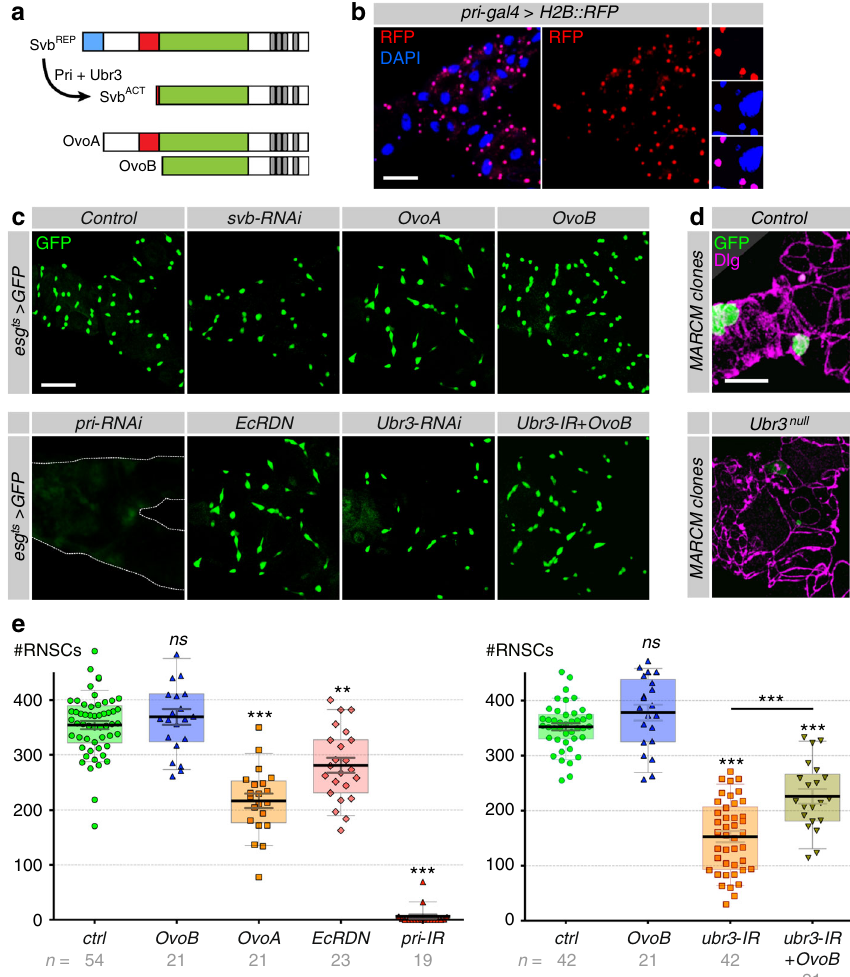
Fig. 3 Processing of Svb is essential for RNSC maintenance. a Schematic representation of Svb maturation, as well as the germinal isoforms OvoA and OvoB that act as constitutive ( pri -independent) repressor and activator, respectively. b Expression of pri monitored by the activity of pri (tal)-Gal4 driving the expression of H2B::RFP (red). Nuclei (DAPI) are in blue. c Fork region of Malpighian tubules, with esg ts -driven expression of GFP and the indicated transgenes, after 8 days of induction. d MARCM clones (GFP-positive) of control and ubr3 B cells, 25 days after induction. e Quanti fi cation of the number of esg + cells per tubule for the indicated genotype. Values are presented as average ± standard error of the mean (SEM) and boxes with whiskers (10 – 90 percentile). Unless otherwise indicated, p values correspond to comparison with control conditions: OvoB ( p = 0.4899), OvoA ( p < 0.0001), EcRDN ( p < 0.0001), pri-RNAi ( p < 0.0001); OvoB ( p = 0.118), ubr3-RNAi ( p < 0.0001), ubr3-RNAi vs ubr3-RNAi + ovoB ( p < 0.0001). p -Values from Mann – Whitney test (ns, P > 0.05; *** P < 0.001). Scale bar is 30 µ